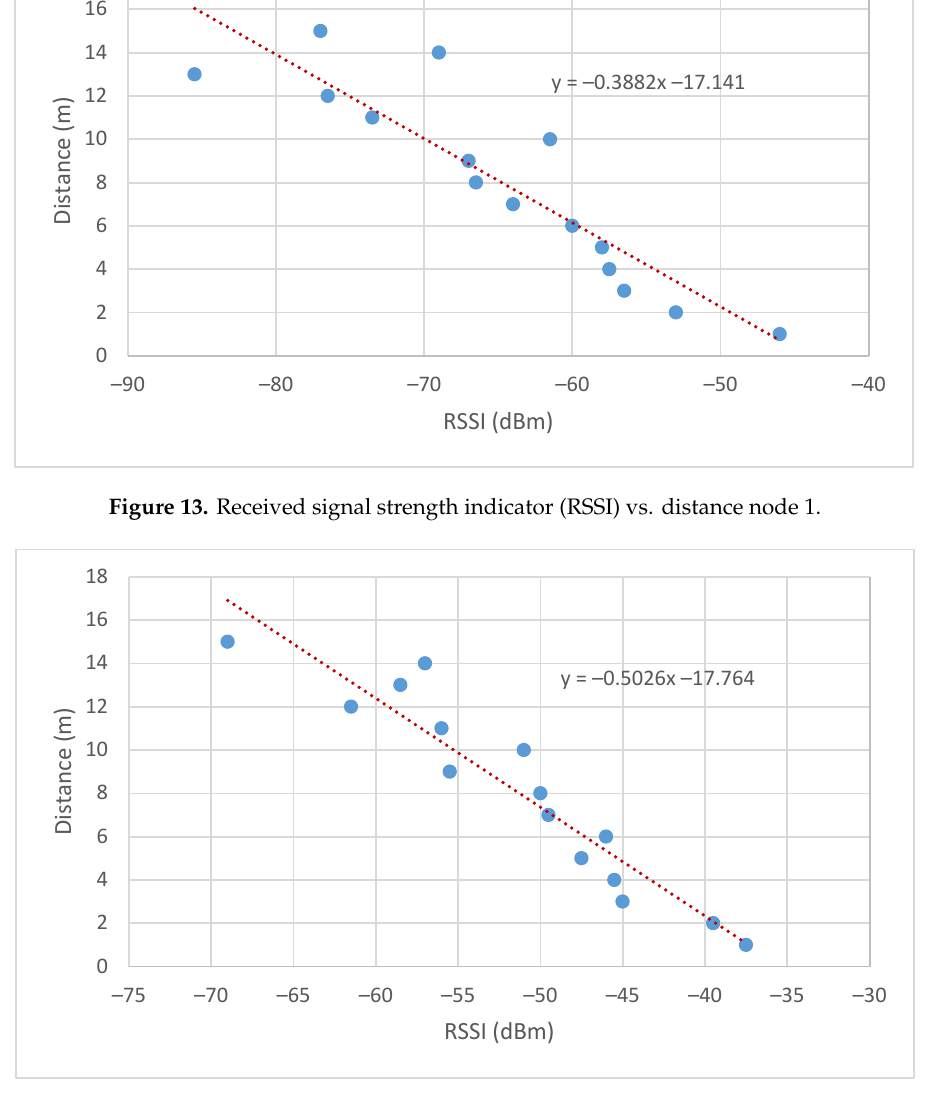
Figure 14. RSSI vs. distance node 2.